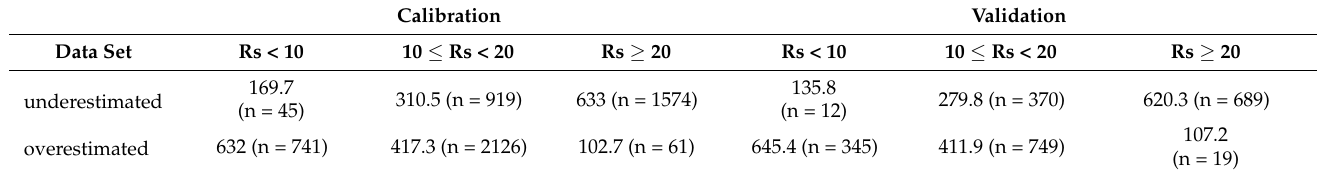
Table 19. RMSE values (J · cm − 2 · day − 1 ) and number of data points belonging to under- and overestimation sets in three defined intervals of measured solar radiation (MJ · m − 2 · day − 1 ) for calibration and validation phases using proposed